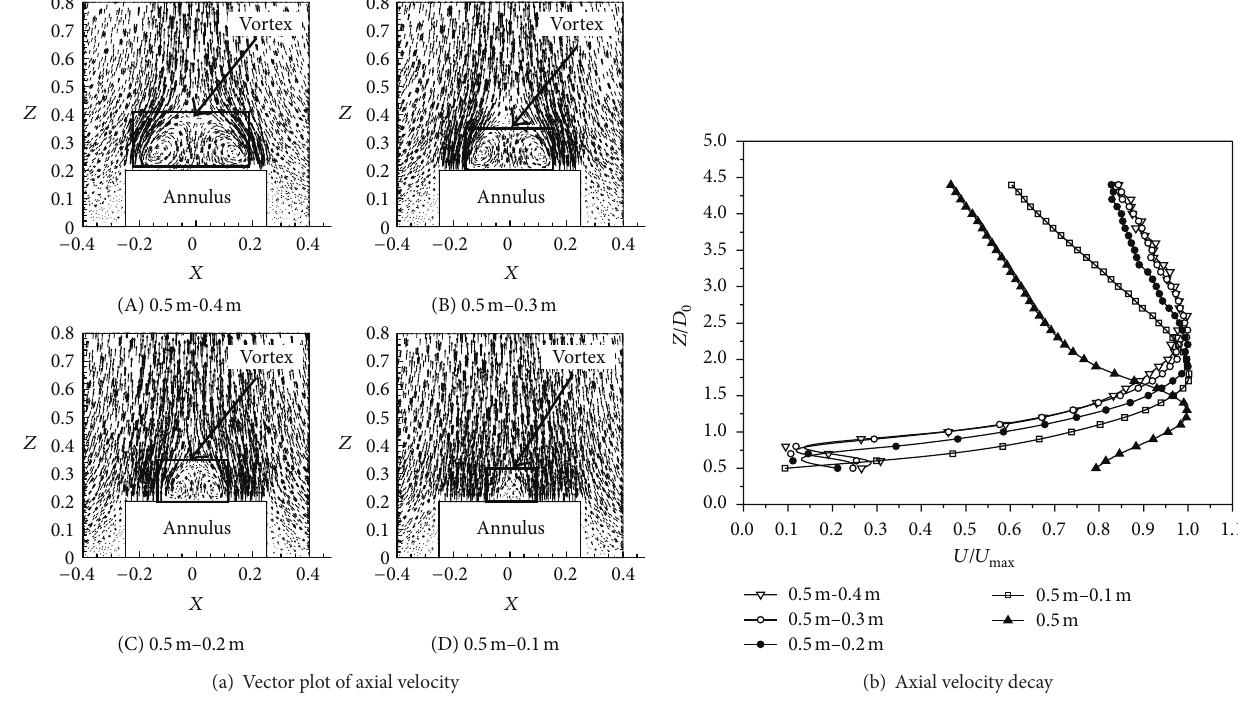
Figure 4: Axial velocity decay of different annular jet